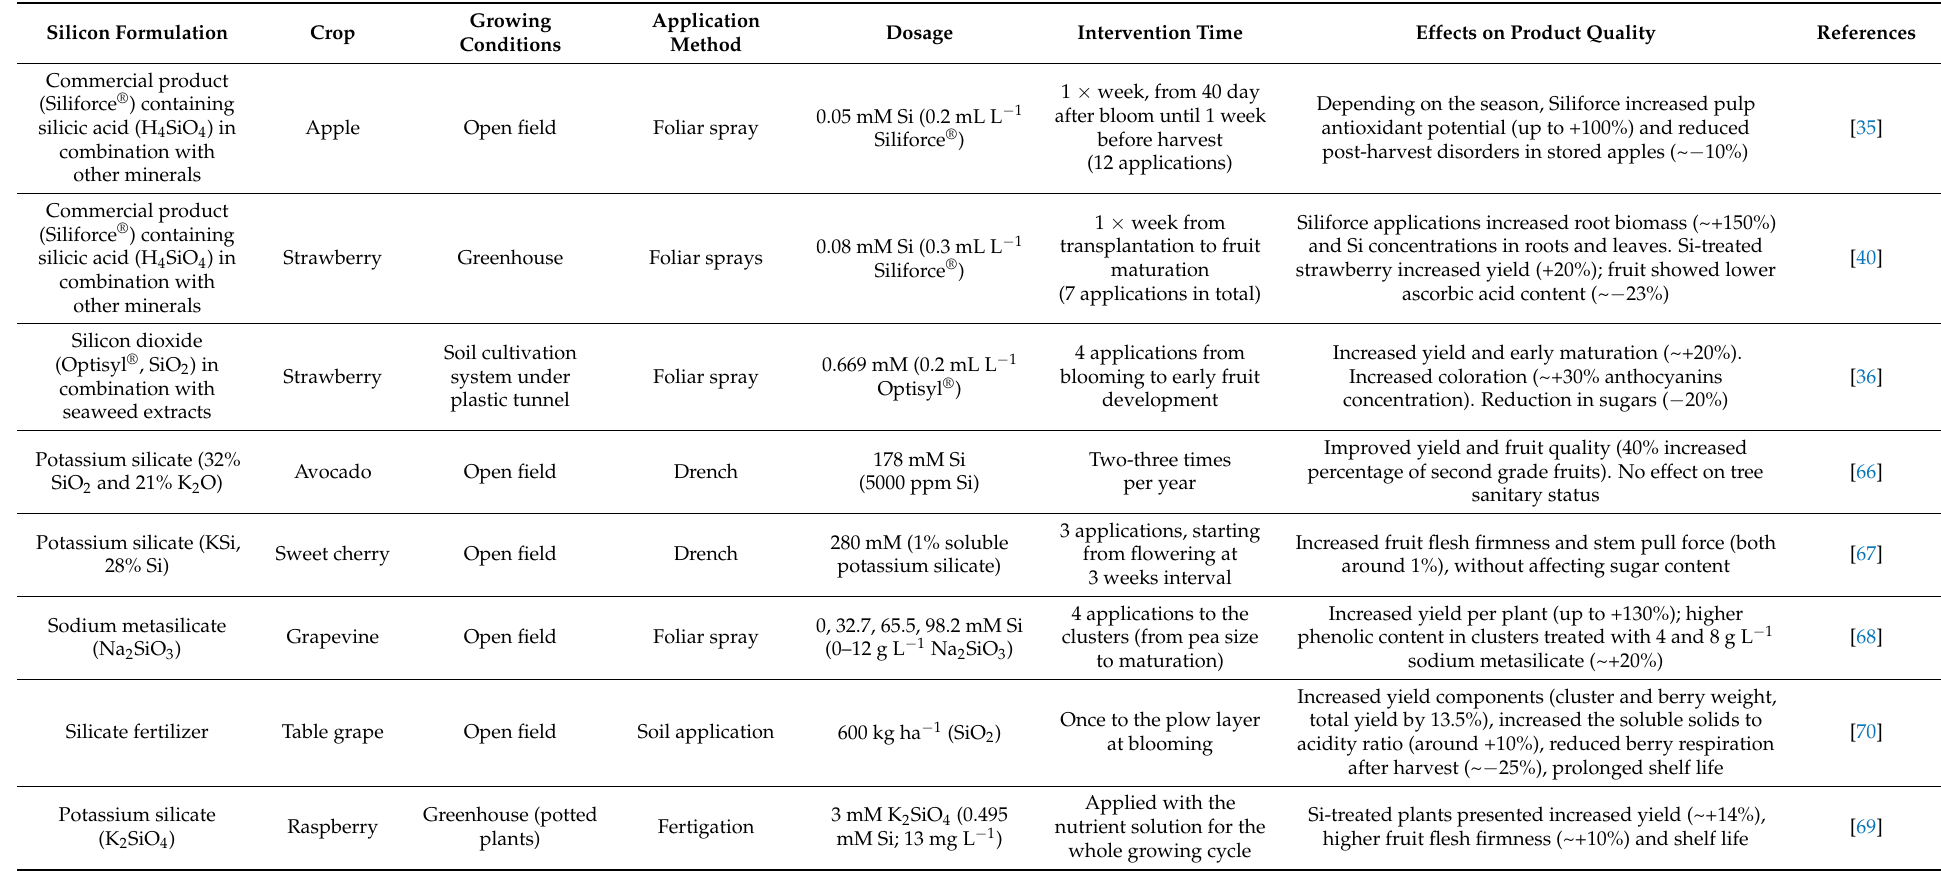
Table 6. Silicon application methods to increase yield and